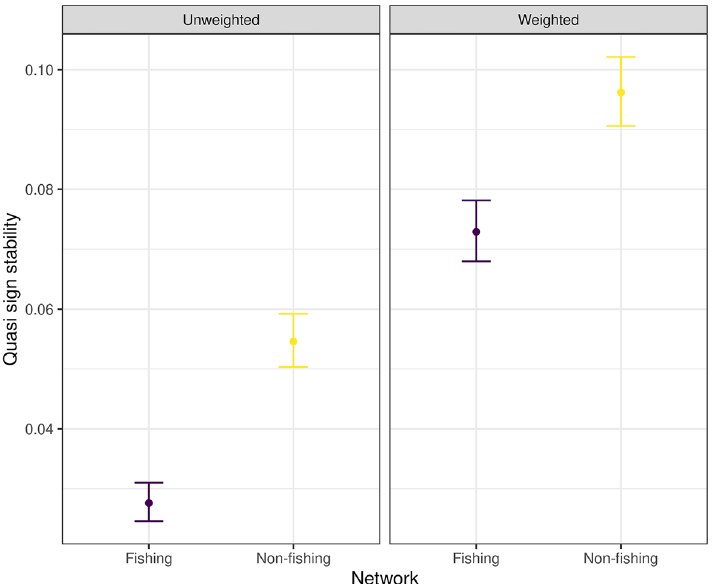
Figure 4. Quasi sign-stability (QSS) values of the fishing and non-fishing food webs. QSS is a measure of the capacity of the system to return to equilibrium after a perturbation, the lower it is the less capacity the